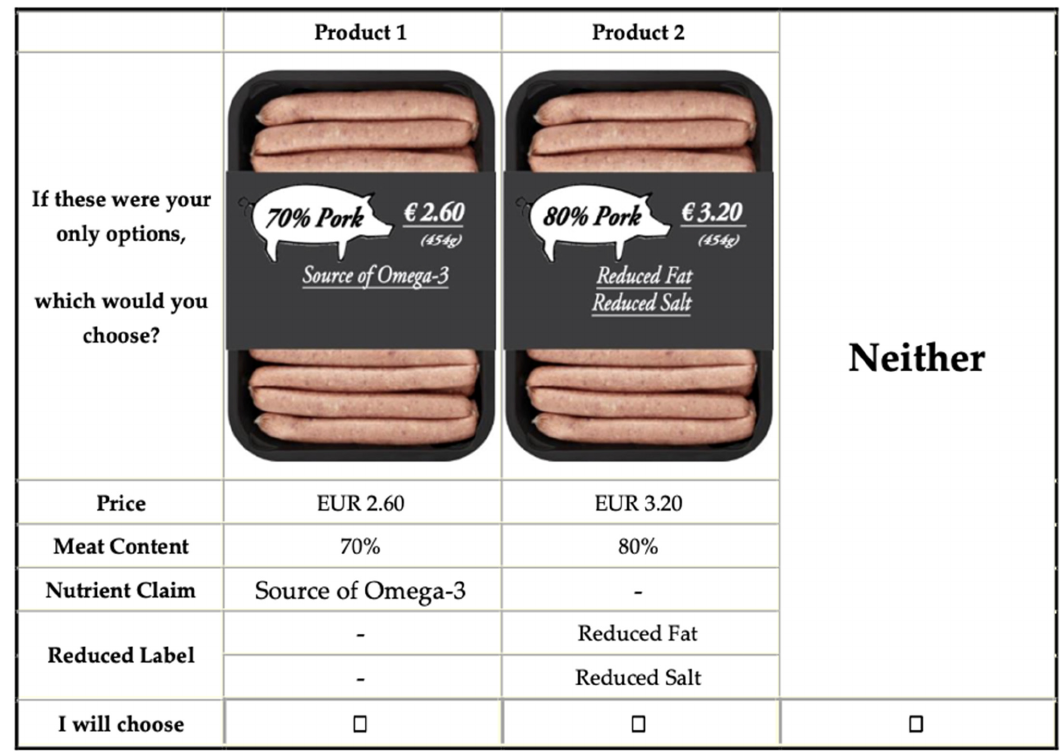
Figure A4. Choice set 4 in the questionnaire.